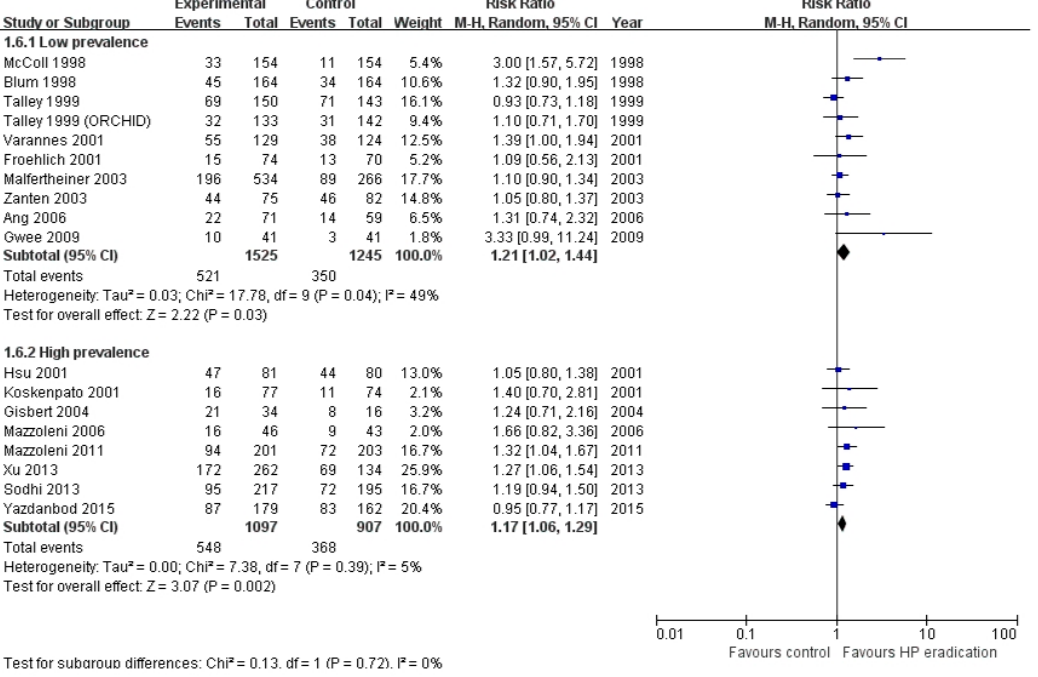
Figure 4. Subgroup analysis by prevalence of H. pylori. 1.6.1. Low prevalence: studies from countries with H. pylori prevalence < 50%. 1.6.2. High prevalence: studies from countries with H. pylori prevalence ≥ 50% ( H. pylori prevalence was estimated from study by Hooi et al.